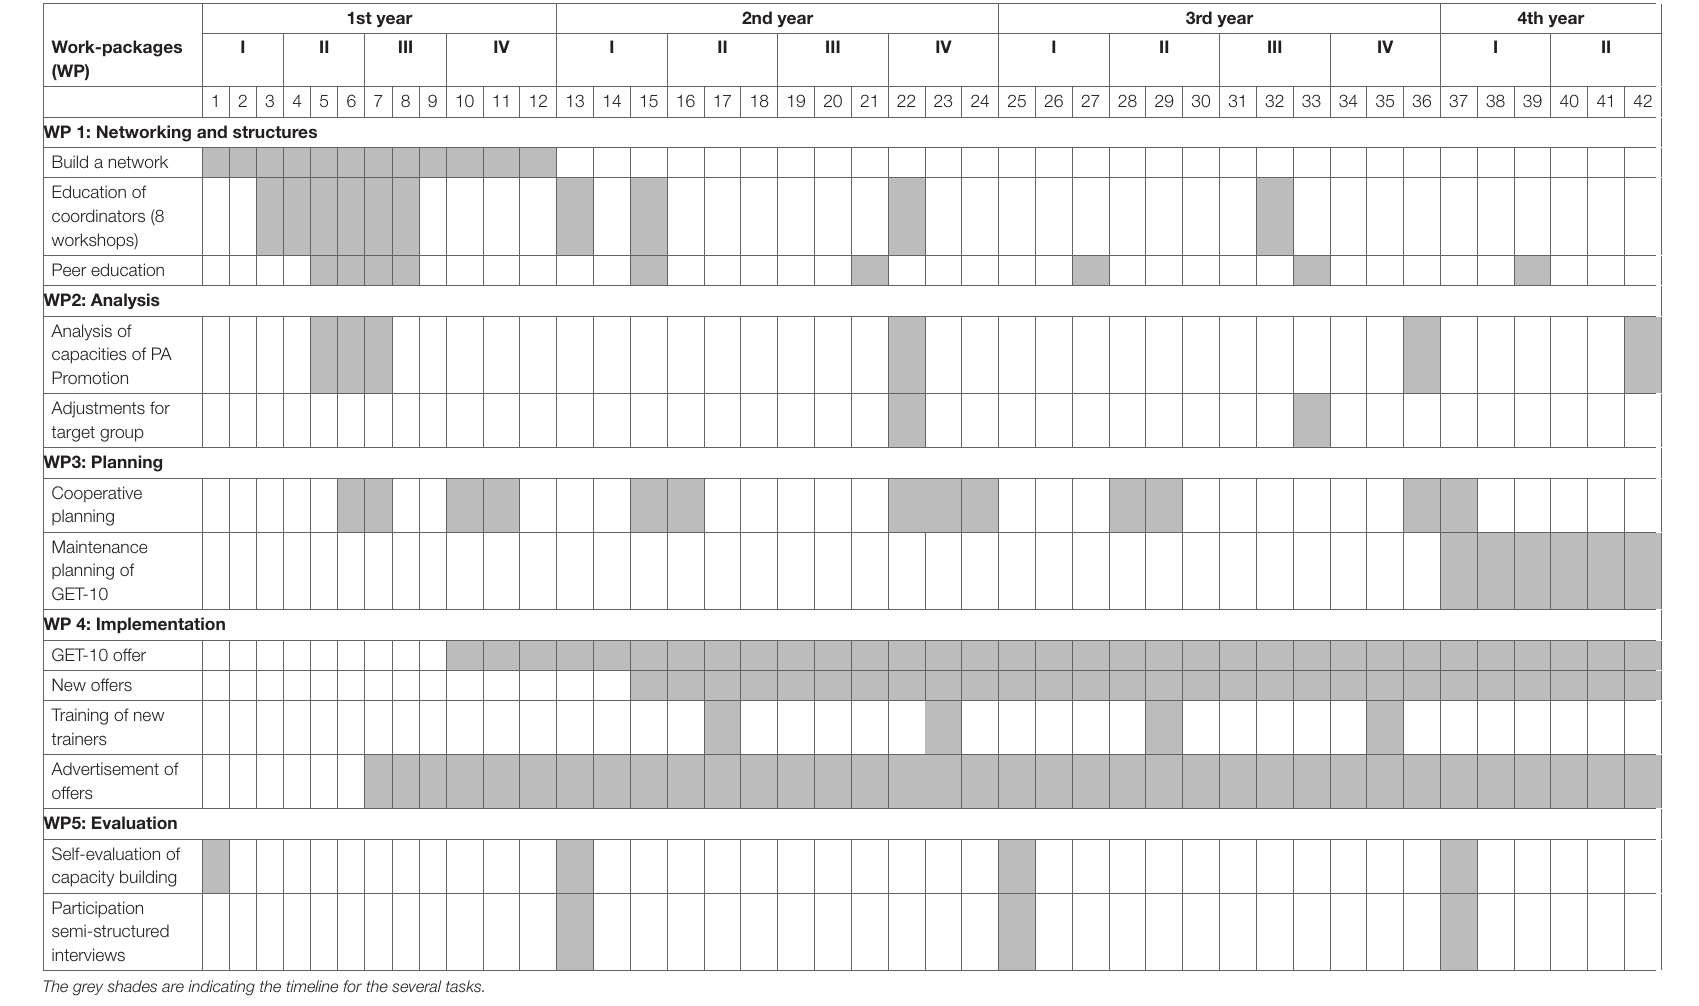
TABLE 2 | GET-10 timeline of project implementation by coordinators.